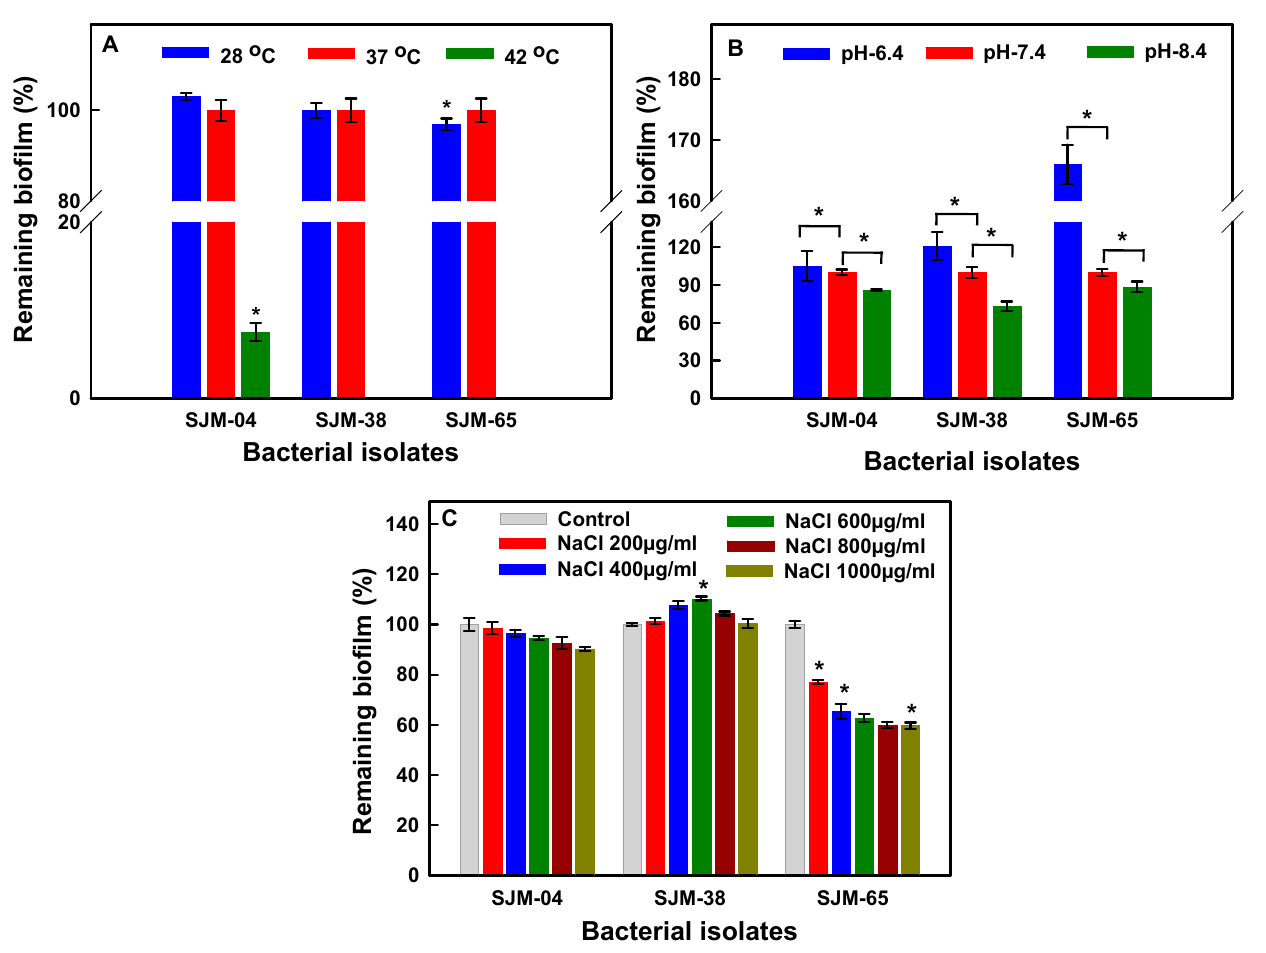
Figure 3. Assessment of biofilm formation as a function of temperature ( A ), pH ( B ), and NaCl concentration ( C ). ‘*’ denotes the statistical difference at p ≤ 0.05 between control and treated groups.